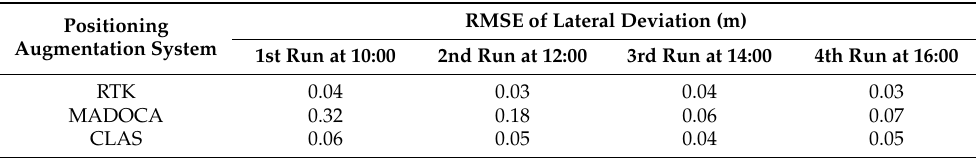
Table 4. Results from dynamic positioning experiments controlled by RTK.